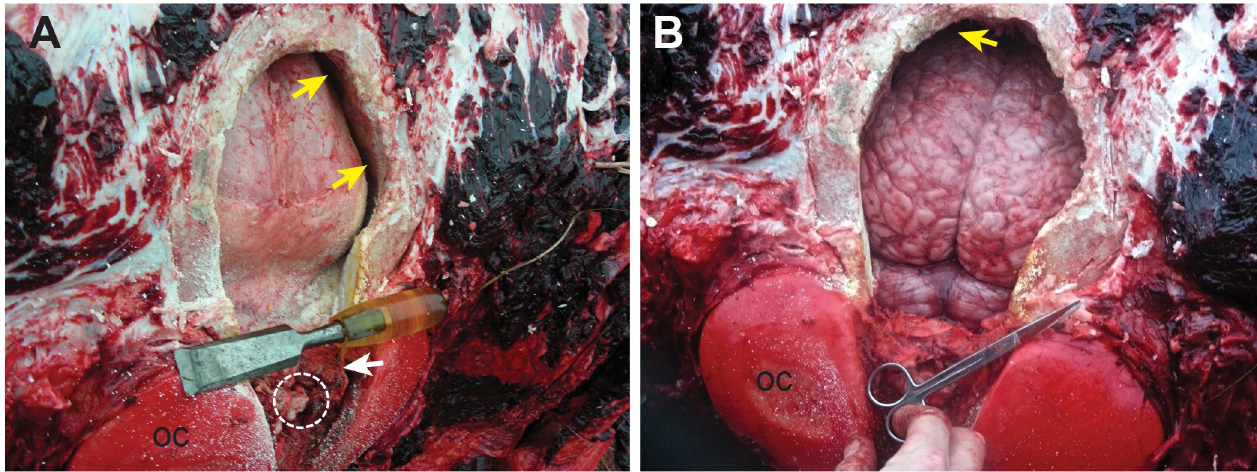
Fig 3. In situ bowhead whale brain. Bowhead (NSB-DWM 2009B11) with the calvarium removed exposing the brain; yellow arrows indicate now empty space between the brain and calvarium; oc, occipital condyle; (A) brain covered by intact dura which has collapsed onto the brain after the cerebrospinal fluid leaked out; note the small size of the spinal cord (white dashed circle) which is surrounded by the cranial rete mirabile (white arrow). (B) brain with dura removed exposing gyri of the cerebrum (upper) and cerebellum and brainstem (lower).